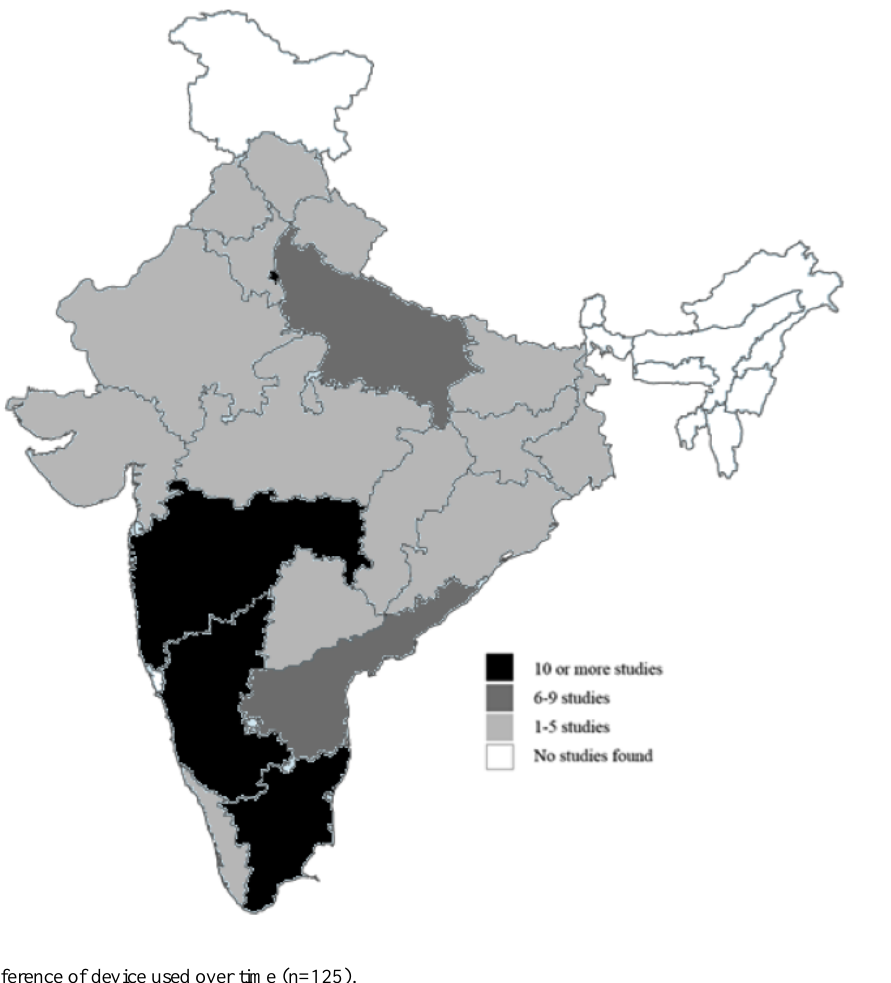
Figure 3. Geographical distribution of the study sites (n=125). Map source: Ministry of External Affairs, Government of India.